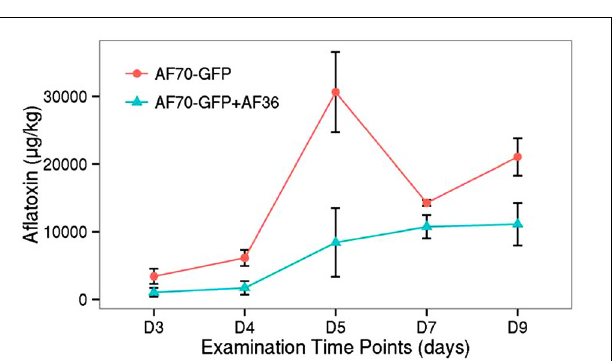
FIGURE 5 |Aflatoxin concentration for co-inoculated corn kernels treated withAF70-GFP + AF36 (green) orAF70-GFP (red) alone from day 3 to day 9 after inoculation. There was a significant treatment effect p < 0.001, and a statistically significant interaction of treatment by day p < 0.001 with α =